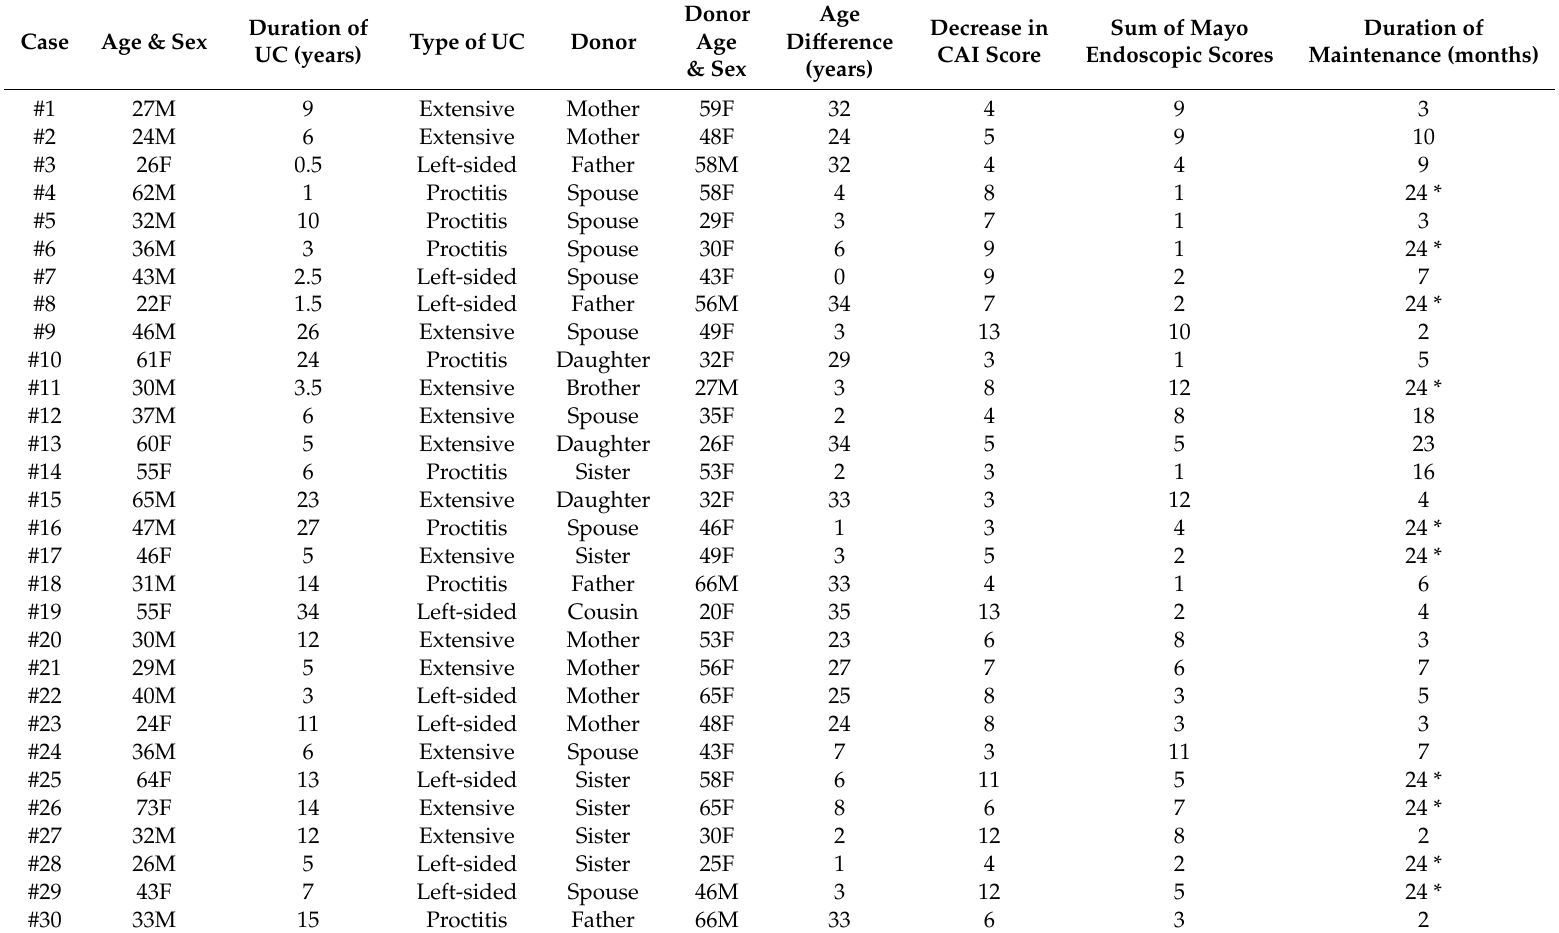
Table 2. Baseline characteristic of responders treated with